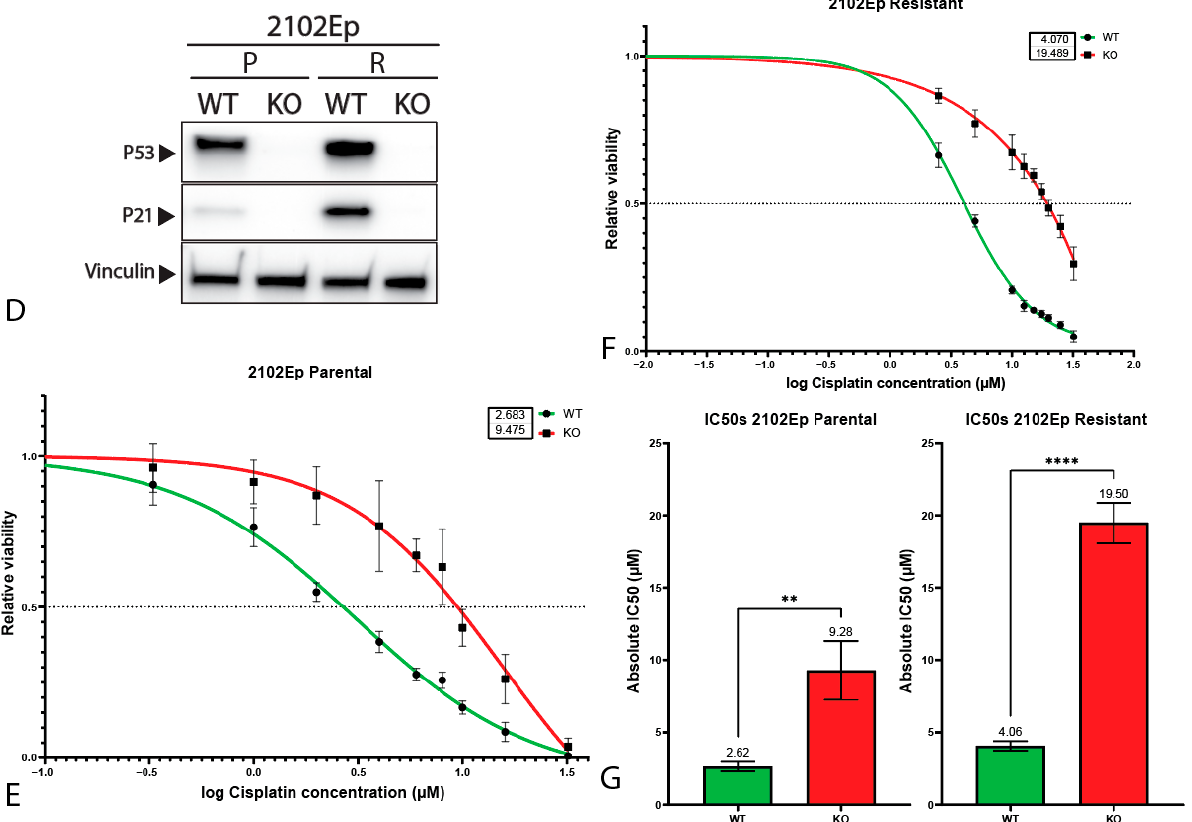
Figure 3. Characterization of 2102Ep TP53 knock-out cell lines. ( A ) SnapGene genome sequence alignments of the CRISPR/Cas9 target site of the TP53 gene. The knock-out cell line (bottom sequence) shows a one-base-pair insertion ( A ) at amino acid 49, resulting in a premature STOP codon at amino acid 51. ( B , C ) Bar graphs showing the fold change in expression between 2102Ep parental cell line and its isogenic TP53 knock-out clone ( B ) or 2102Ep-resistant cell line and its isogenic TP53 knock-out clone ( C ). ( D ) Western blots showing the protein levels of P53, P21 and vinculin (as loading control) in 2102Ep parental and resistant cell lines and their isogenic TP53 knock-out clones. ( E , F ) S-curves showing the viability of the parental ( E ) and resistant ( F ) 2102Ep cell lines and their corresponding knock-out when treated with cisplatin for 72 h. Graphs represent three biological replicates with three technical replicates each. ( G ) Bar plots displaying IC50 values of all 2102Ep cell lines. Both cell line pairs show significant differences in IC50 values after knock-out (parental p = 0.0049, resistant p ≤ 0.0001, unpaired Student’s t -test). Mean ± SD: 2102Ep parental 2.62 ± 0.33, 2102Ep parental TP53 KO 9.28 ± 2.02, 2102Ep resistant 4.06 ± 0.32, and 2102Ep resistant TP53 KO 19.50 ± 1.36. Graphs represent three biological replicates with three technical replicates each. ** p ≤ 0.01, **** p ≤ 0.0001.